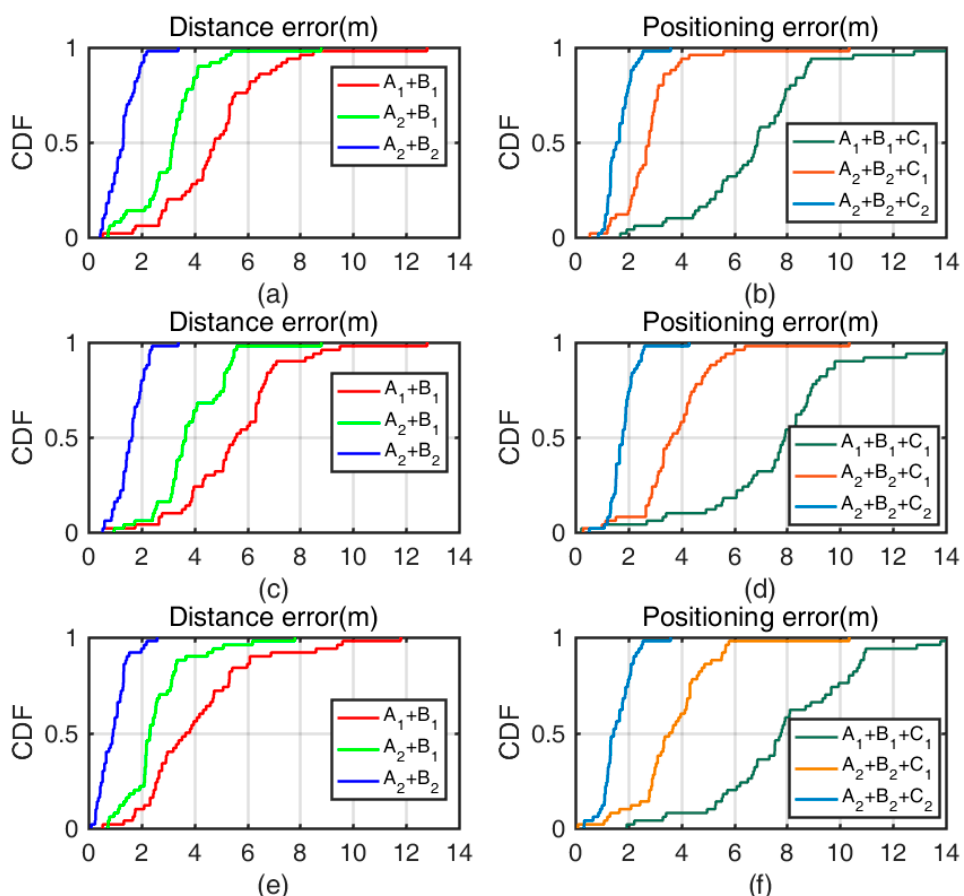
Figure 11. CDF values of the distance error and positioning error when using the ( a,b ) Google Pixel 3 L in scenario #1; ( c,d ) Huawei P20 in scenario #1; and ( e,f ) Google Pixel 3 L in scenario #2.